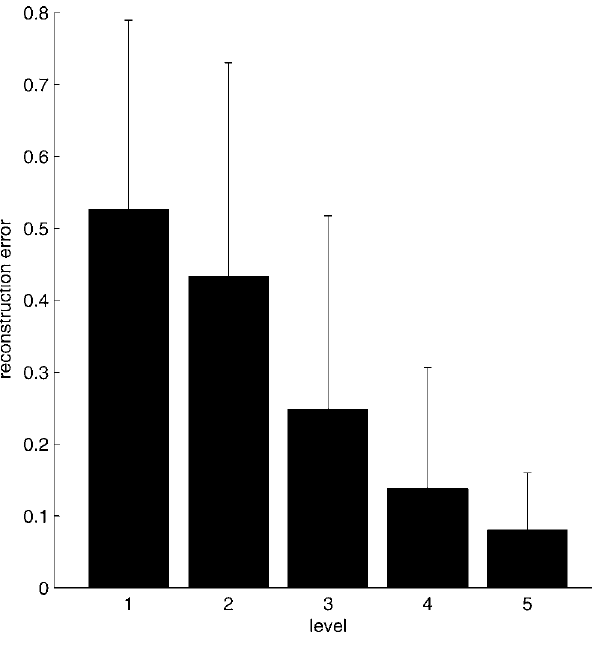
The position of the robot is reconstructed using the responses of the N l ¼ 2 9 (cid:3) l units in the different levels l ¼ 1 ... 5 of the processing hierarchy using a standard Bayesian framework (see text). The reconstruction error, defined as the Euclidean distance between the true and the reconstructed position, is shown as a function of the hierarchical level. The error bars indicate the standard deviation from the mean. DOI: 10.1371/journal.pbio.0040120.g006